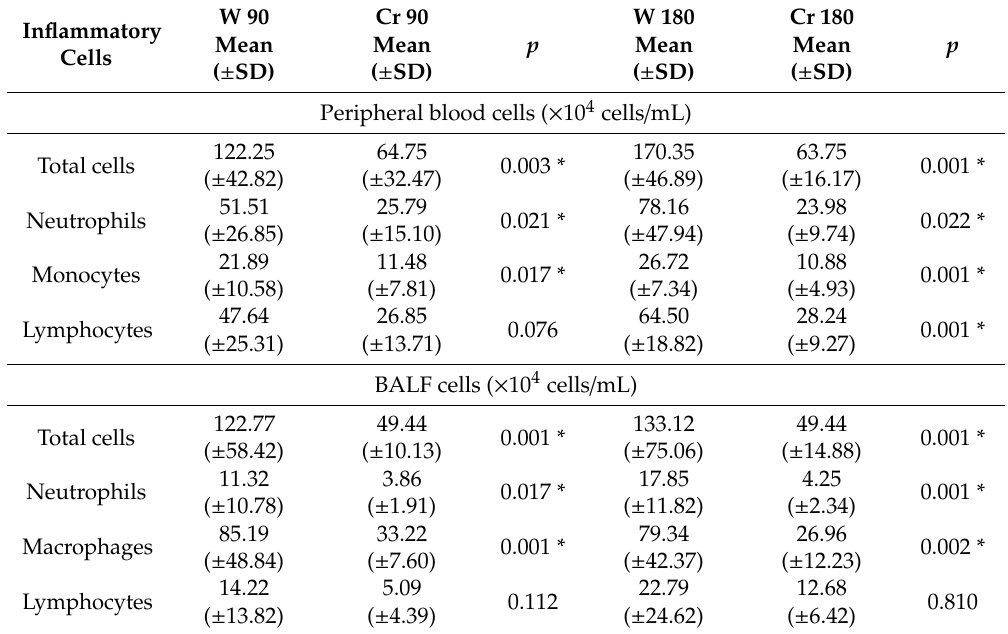
Table 4. Peripheral blood and bronchoalveolar lavage fluid (BALF)